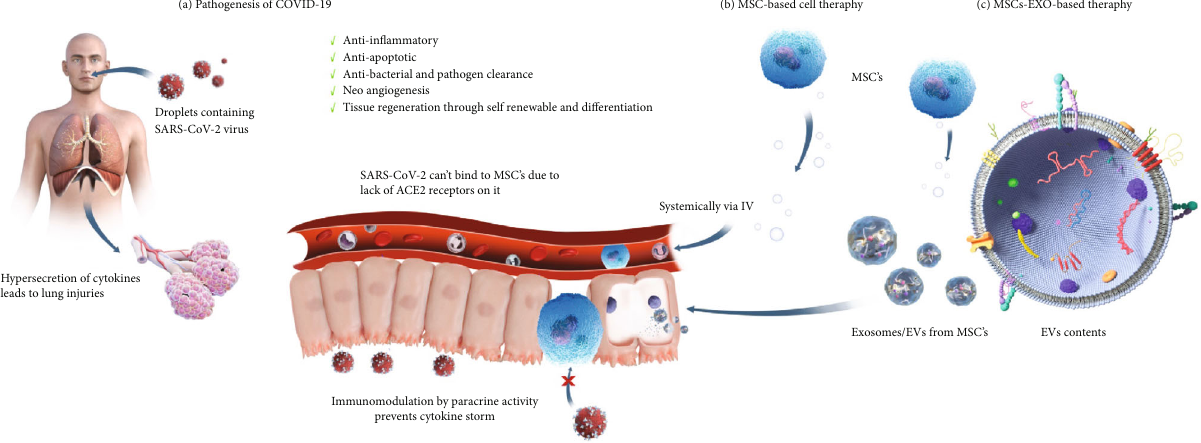
Figure 1: Pathogenesis of COVID-19 and stem-cell-based therapy. ( a). SARS-CoV-2 enters into the human body via droplets from infected patients. In human cells, SARS-CoV-2 binds with the ACE2 receptors present on host cells and initiates a cytokine storm. This storm results in severe lung injury. ( b). MSCs. ( c). MSCs-Exo or EVs are considered a possible future treatment due to many of their properties, such as a lack of ACE2 receptors (which prevents a cytokine storm) and immune modulation and restoration of damaged cells due to their essential growth factors and metabolites, see Supplemental Video 1 for the proposed mechanism of MSCs-Exo in treating COVID-19